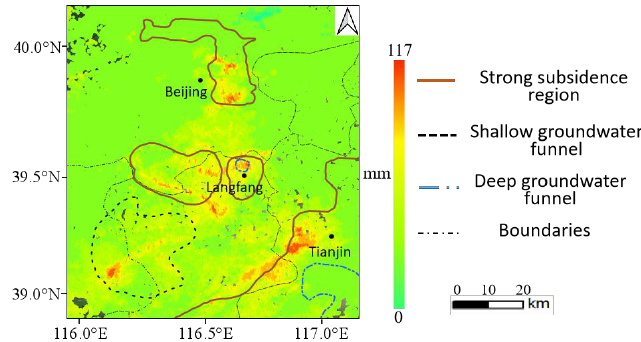
Figure 11. The distribution of deep and shallow ground water, the major subsidence region in Beijing-